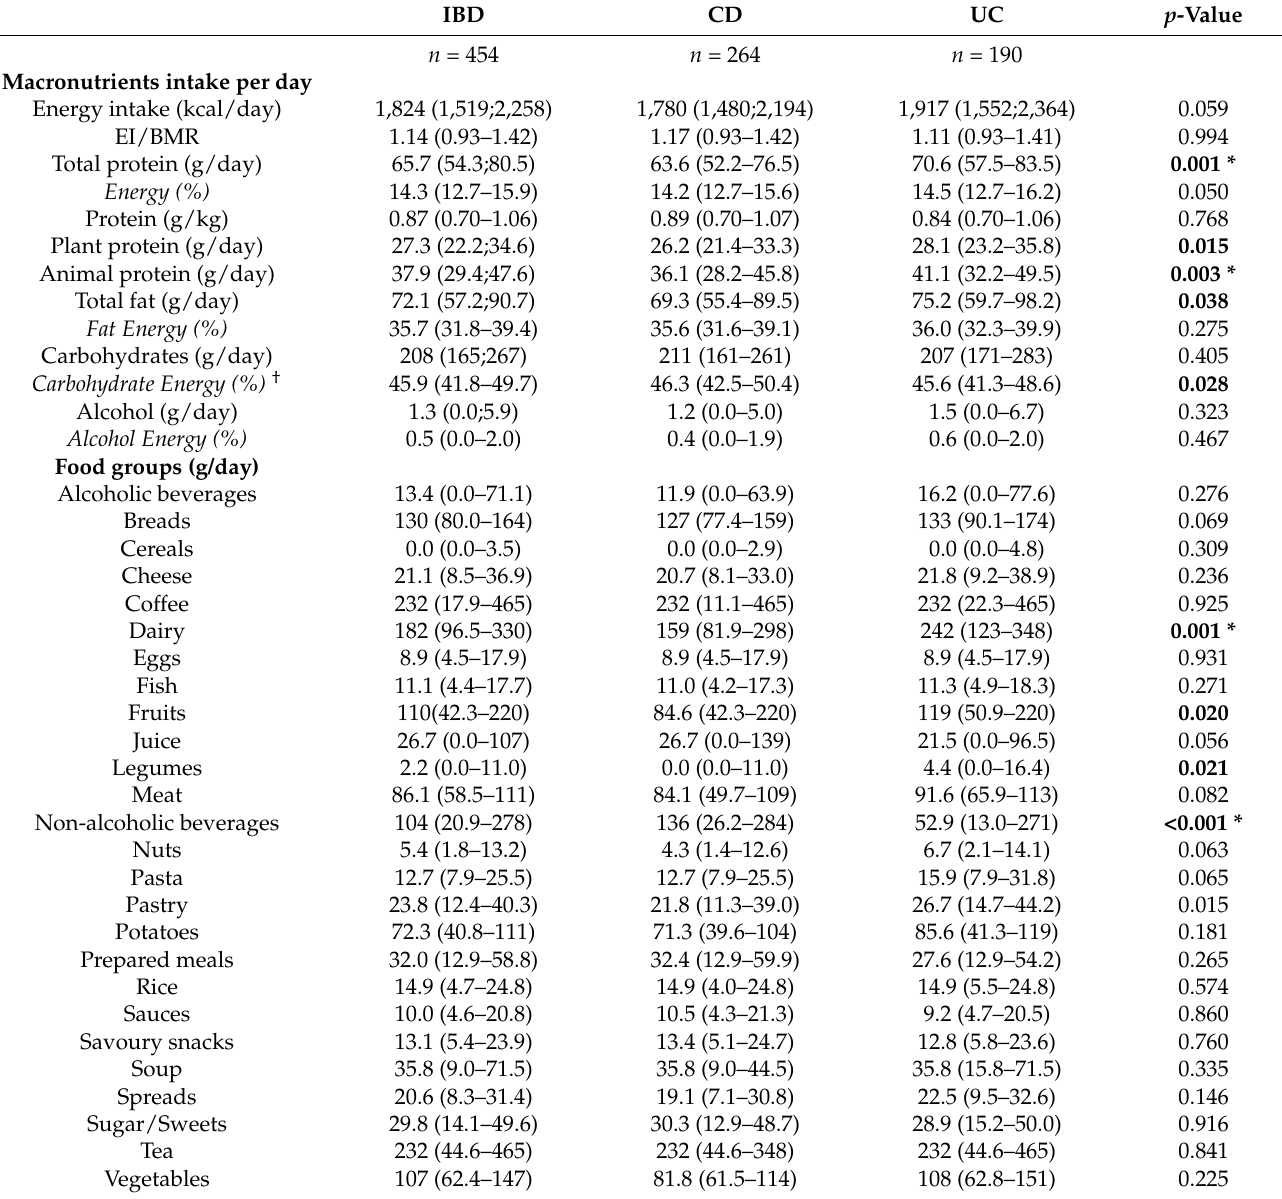
Table 2. Habitual dietary intake of the full cohort and for patients with CD and UC